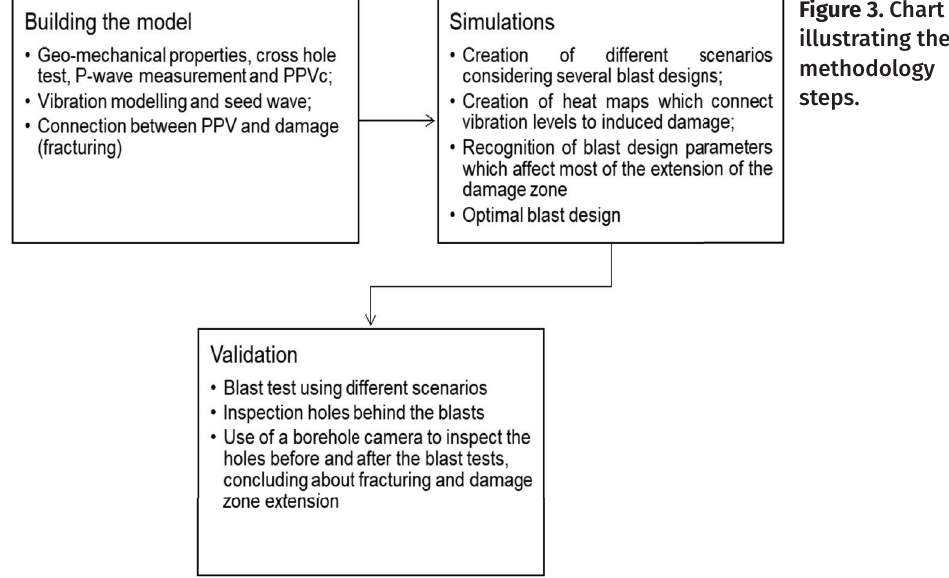
Figure 3. Chart illustrating the methodology steps.